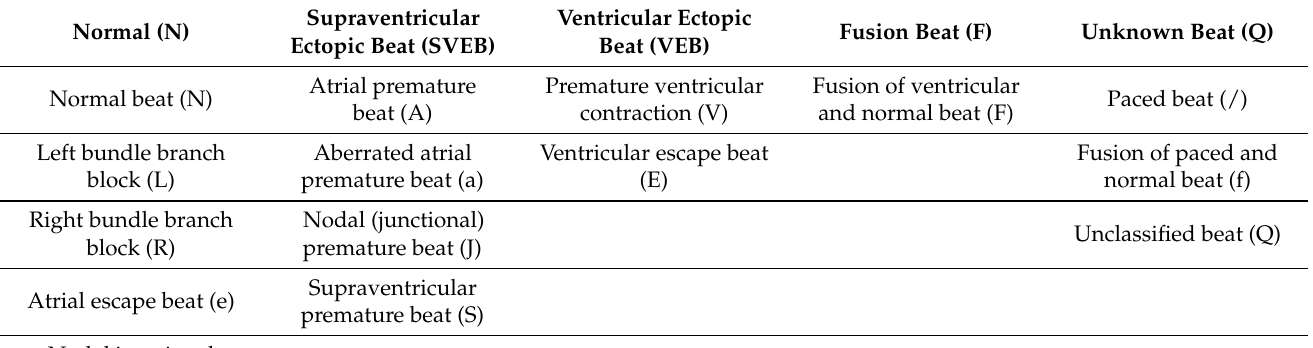
Table 1. AAMI recommendation of